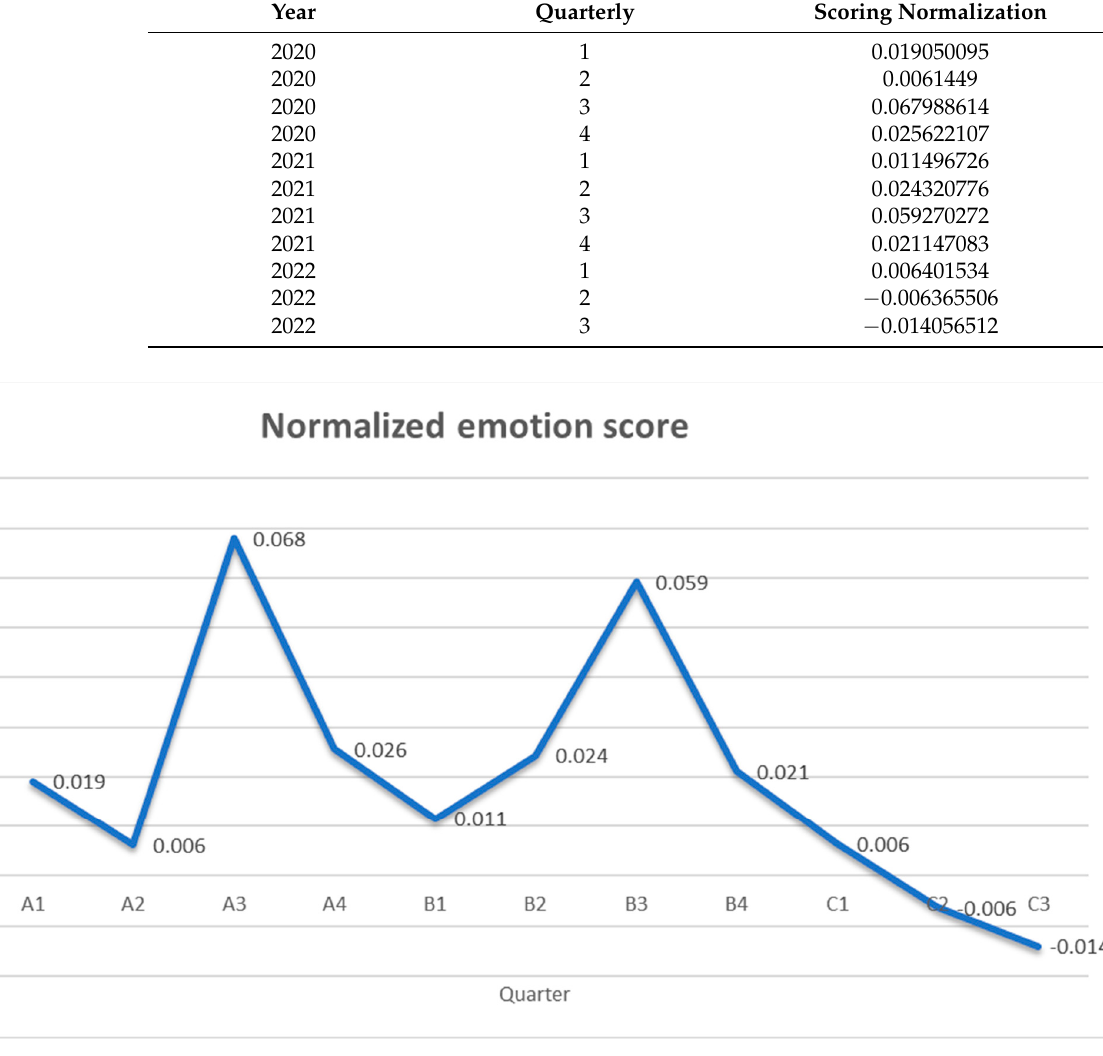
Figure 2. Statistical chart of changes in sentiment values of A1 −